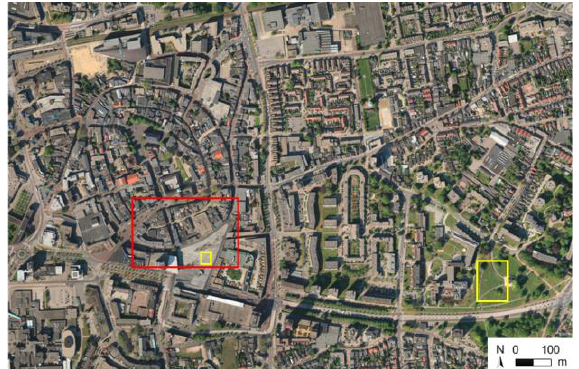
Figure 1. Orthoimage of the study area. The two regions within the yellow rectangles are used in Section 3.1. The region within the red rectangle is used in Section 3.2. The potential DTM accuracy of the whole area is evaluated in Section 4. The area for the two yellow regions, red regions and the whole study region is 880 m 2 , 6624 m 2 , 0.04 km 2 , 1.6 km 2 ,